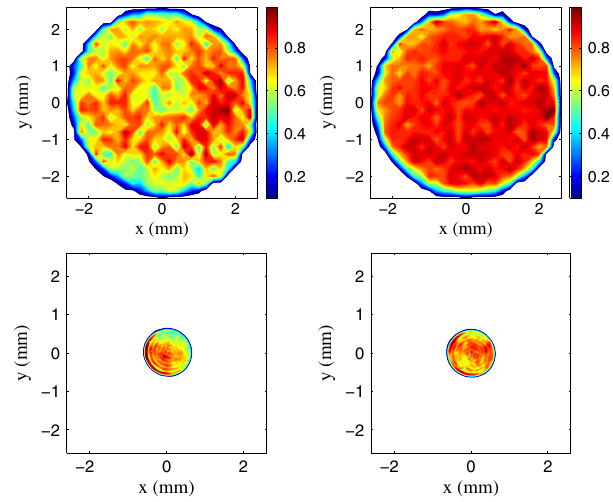
FIG. 21. Upper row: QE maps of the used cathode #110.2 (left) and the fresh cathode #11.3 (right). Bottom row: corresponding transverse laser intensity distributions at these cathodes used for emittance measurements.